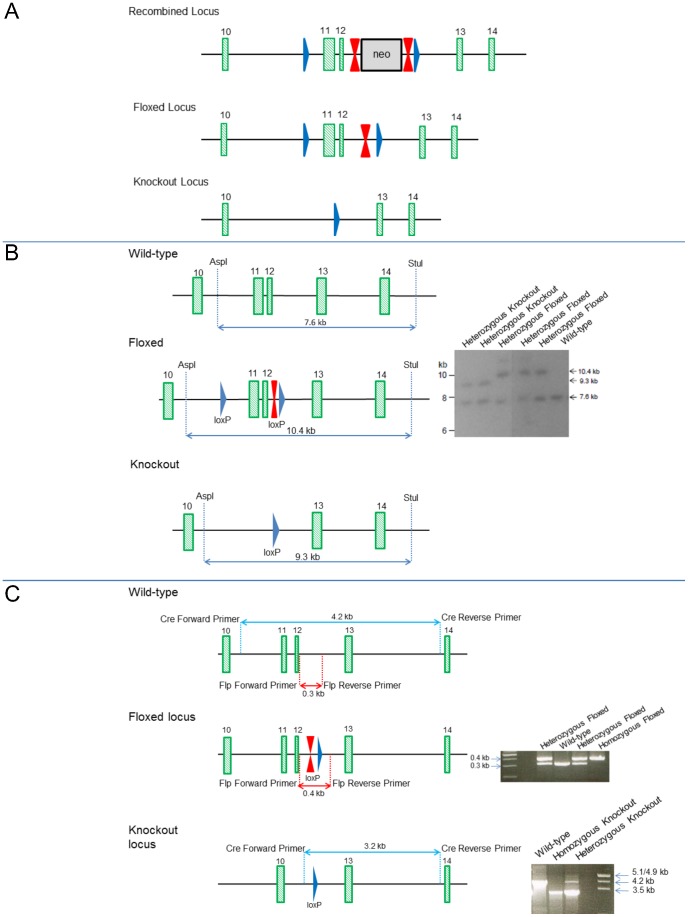
Loci from Hltf floxed and constitutive knockout mice.Panel A, recombined allele in F1 mice, i.e. FRT-flanked (double red triangles) Neo resistance selection cassette is downstream of exon 12, and two loxP sites (blue triangles) are upstream of exon 11 and downstream of exon 12. Exons are numbered green rectangles. Next, the floxed allele in F2 mice results from breeding F1 mice with Flp recombinase-expressing C57BL/6J Flp deleter mice to remove the Neo resistance cassette. Lastly, the knockout allele (F3 mice) results from breeding F2 heterozygous Neo-excised Hltf-floxed mice to C57BL/6J mice expressing Cre recombinase under the control of the CMV promoter. Panel B, schematic of the Hltf wild-type, floxed, and knockout alleles with restriction sites for the 3′-Southern blot strategy. Southern analysis was performed with DNA digested with Asp1-Stu1, blotted on nylon membrane, and hybridized with the 3′- probe detecting the Asp1-Stu1-fragments of expected sizes (kb). Panel C, schematic of genotyping by PCR shows wild-type, floxed and knockout alleles with primer locations, and expected amplicon size. PCR amplicons for each genotype are provided with DNA size markers.